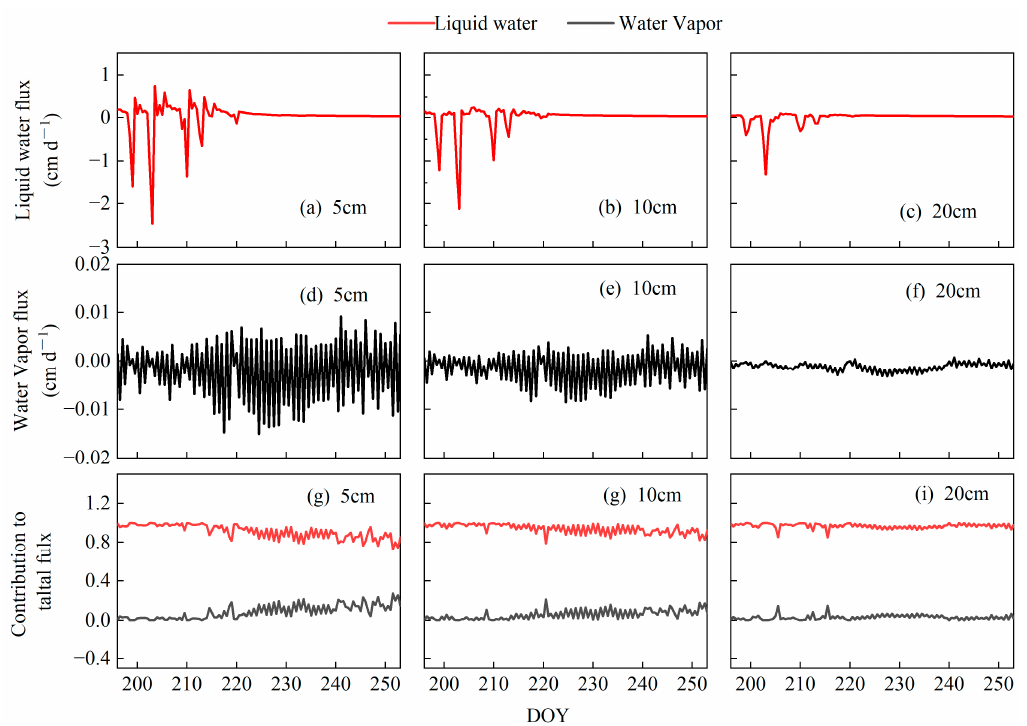
Figure 8. Liquid water and water vapor fl uxes and their proportions at 5 cm ( a , d , g ), 10 cm ( b , e , h ) and 20 cm ( c , f , i ) for BT. All fl uxes are positive in the upward direction.